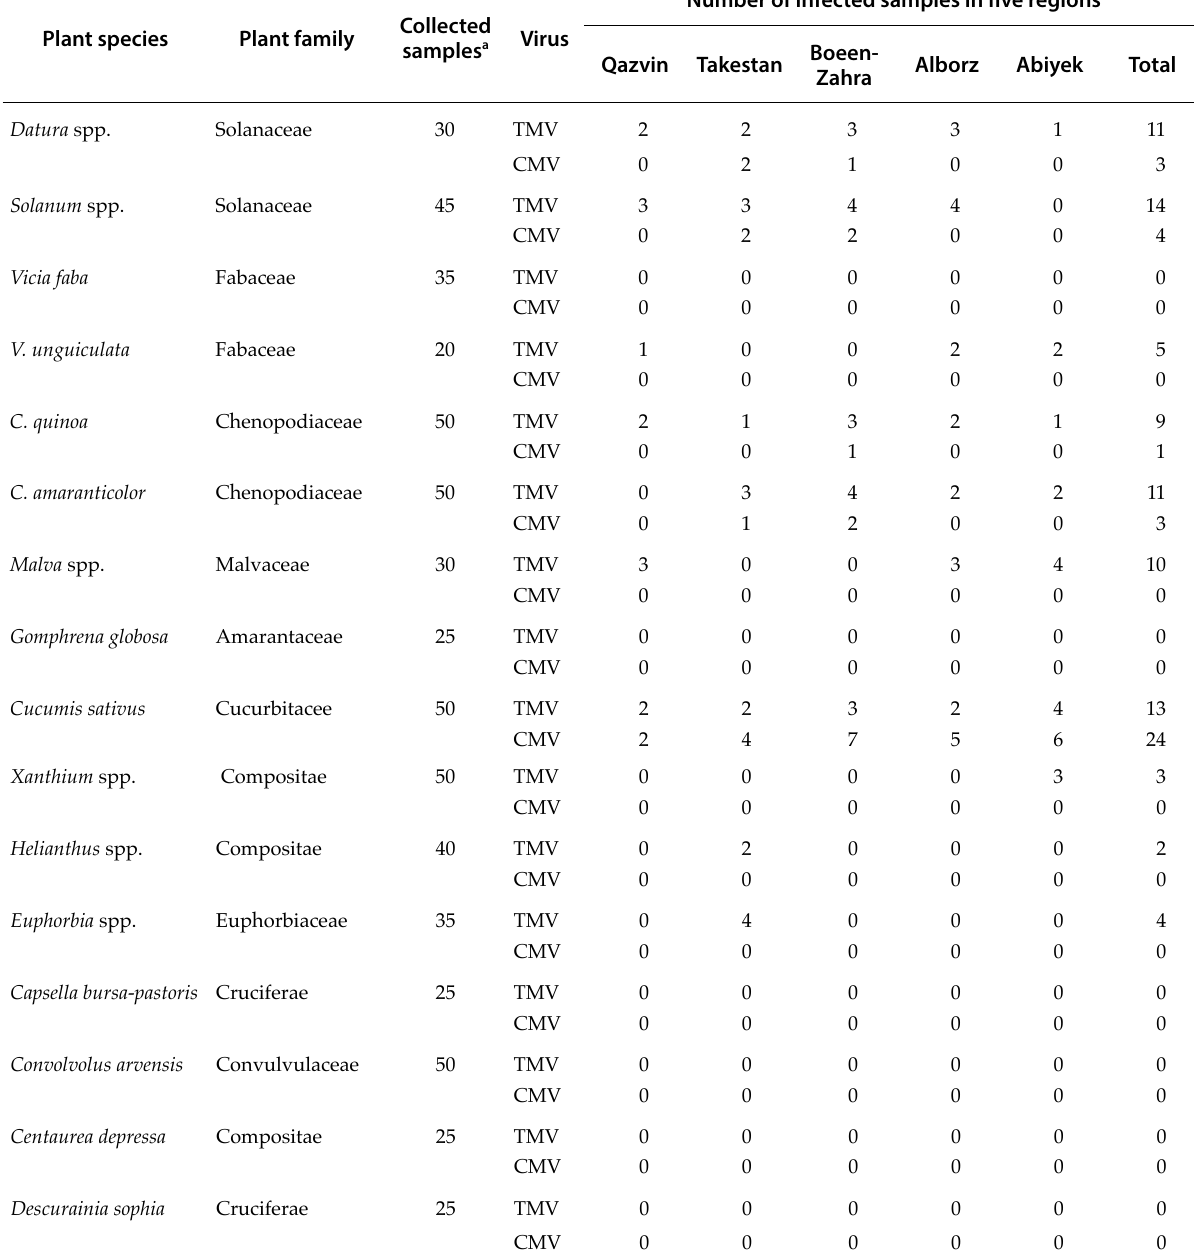
Table 3. Natural hosts collected during the survey for viruses in Qazvin province. Results of serological tests on with spe- cific polyclonal antibodies of each virus are